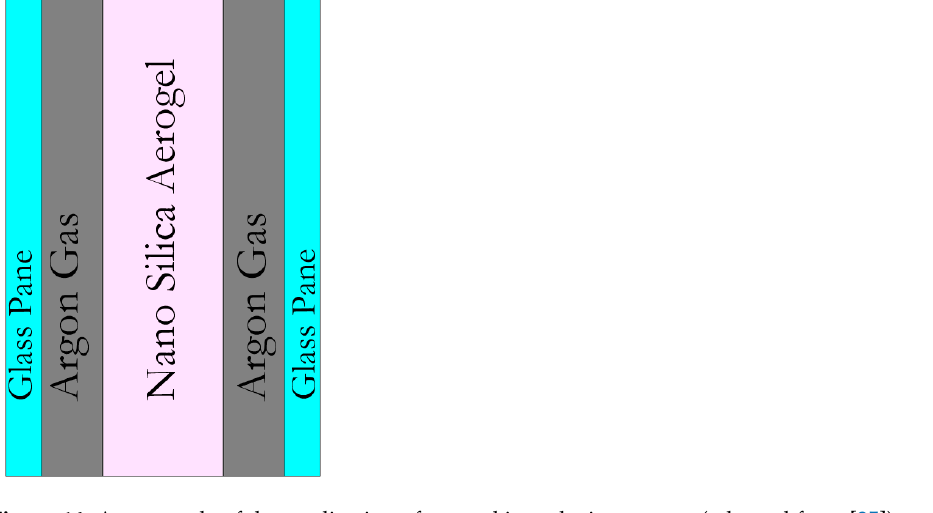
Figure 14. An example of the application of aerogel in a glazing system (adopted from [35]). Aerogel can also be used in opaque components. Fenoglio et al. [40] studied the ap- plication of aerogel as an additive in plasters or fillers in hollow construction units such as bricks. The aerogel used in their study has conductivity and specific heat of 0.027 W/m·K and 998 kJ/kgK, respectively. Their results showed a 4.5-cm thick aerogel layer duction of about